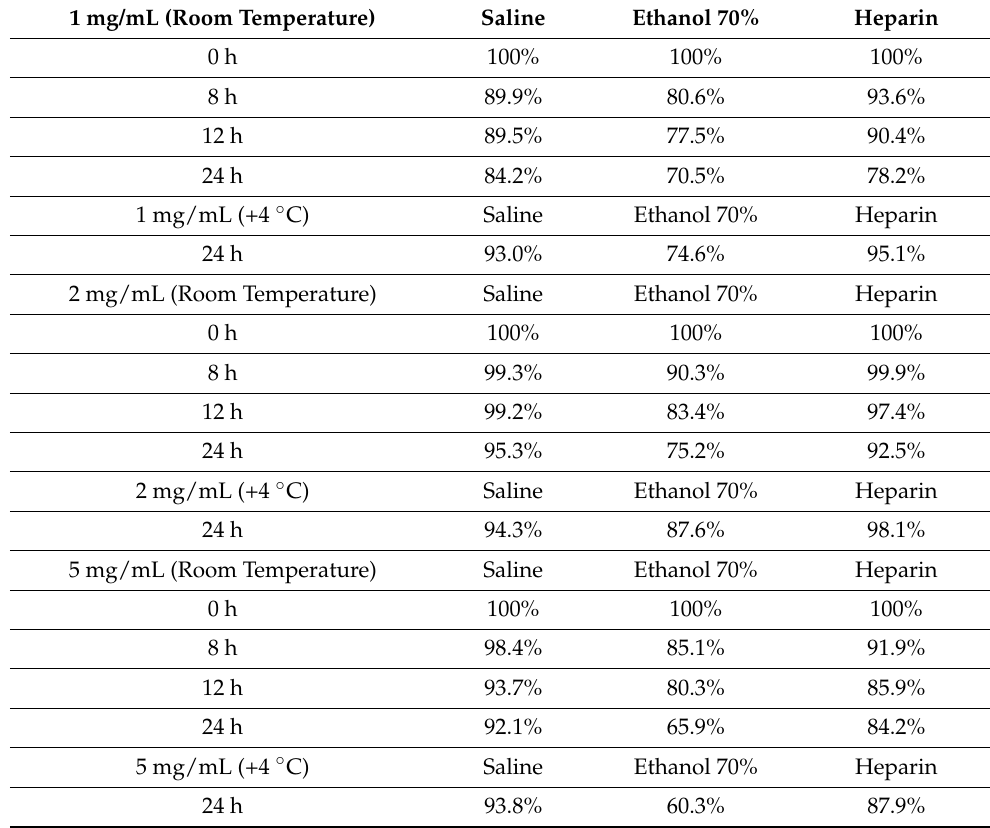
Table 2. Stability testing of meropenem for its use during lock